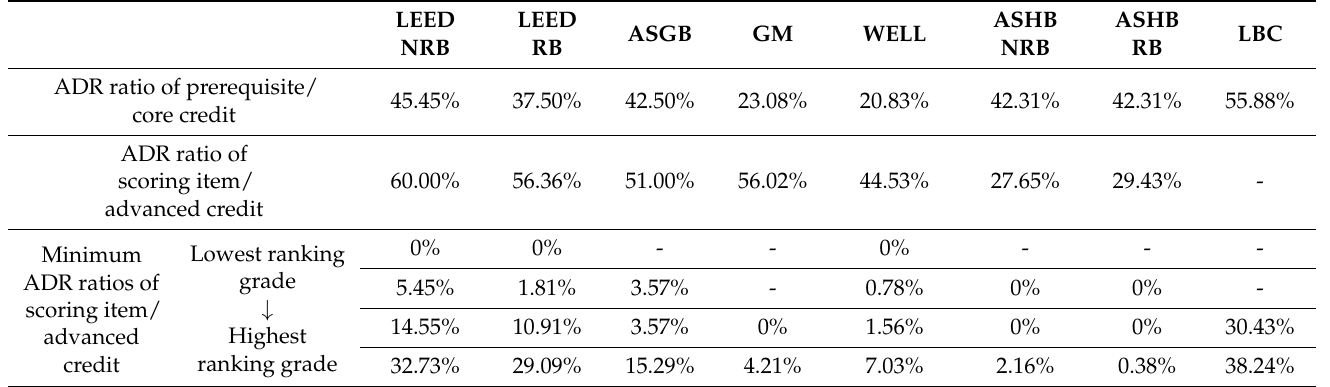
Table 3. ADR ratios and minimum ADR ratios in GBRSs. (Source: by the